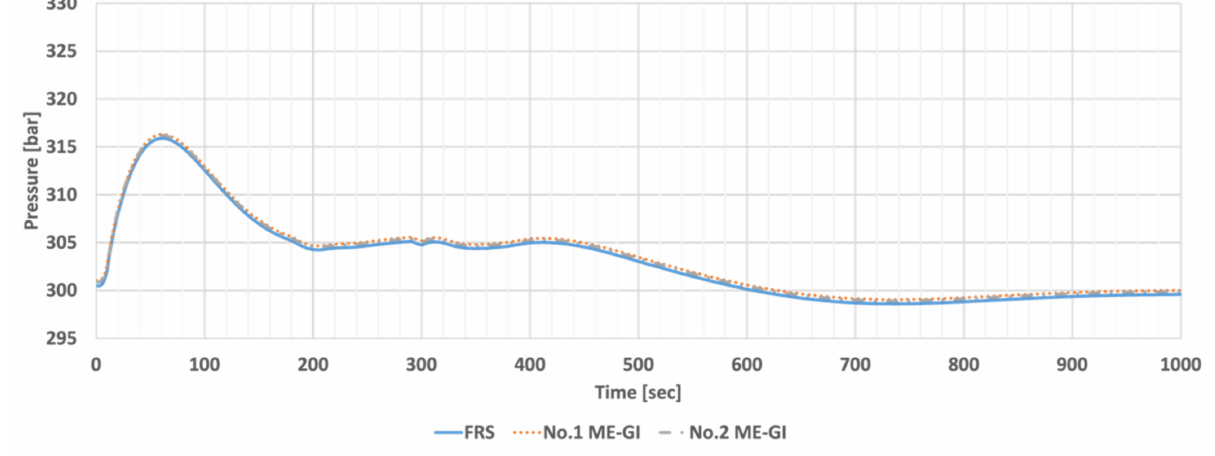
Figure 9. Pressure of each line when one engine is